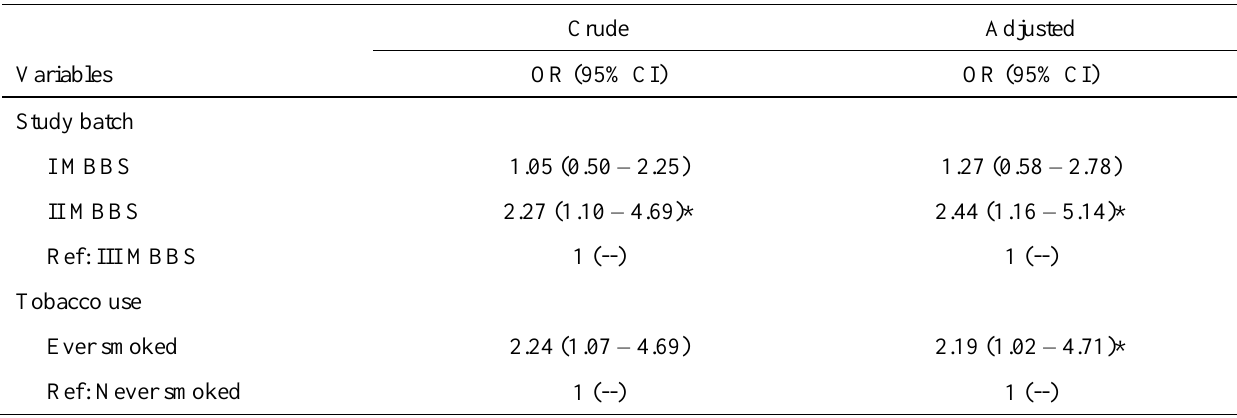
Table 6: Logistic regression of predictors of dyspepsia